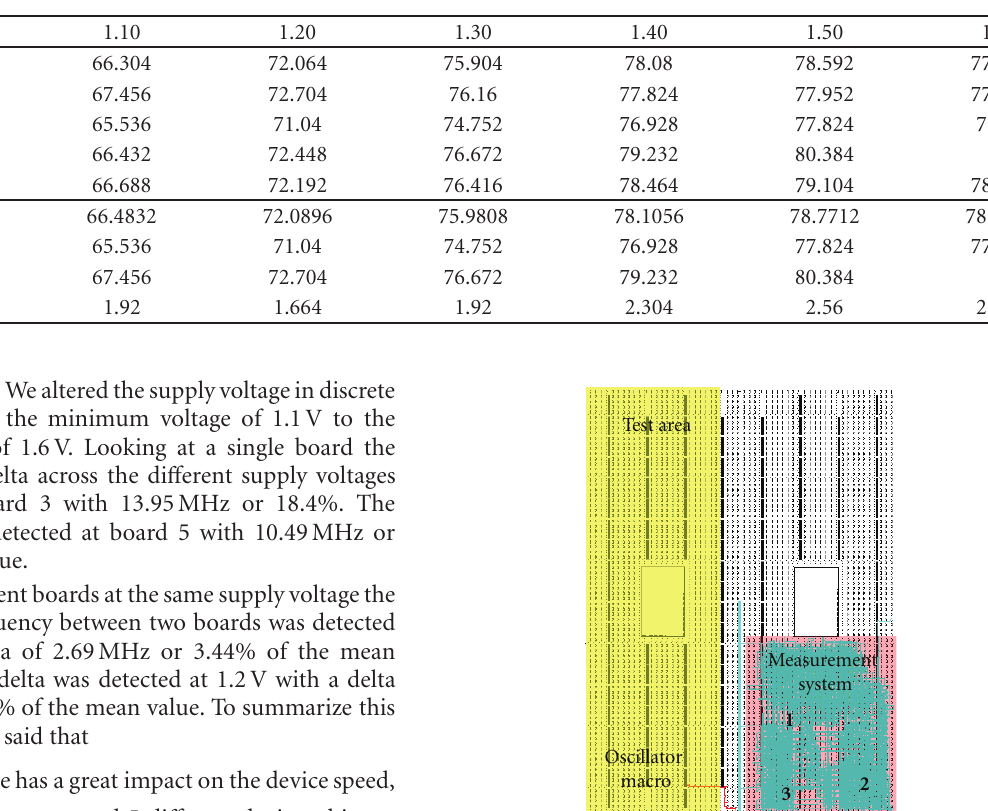
Table 2: OSC macro 2 frequency (MHz).